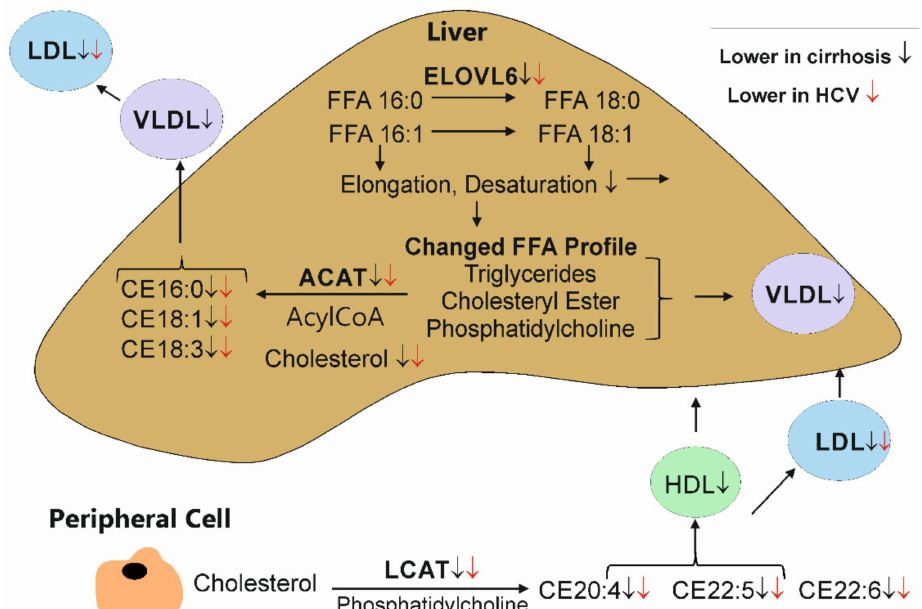
Figure 9. Pathways which may contribute to the altered CE profile in HCV and liver cirrhosis. Free cholesterol in the liver is converted to CEs by ACAT, which produces atherogenic CE species. These are released from the liver by VLDL, which is converted to LDL in the circulation. Elongation of very-long chain fatty acids (ELOVL) 6 was found to belower expressed in the fibrotic liver, and activity of further elongases and desaturases may be impaired. Free fatty acids (FFA) are used for the synthesis of various lipid classes such as triglycerides, diacylglycerols, cholesteryl ester and phosphatidylcholine. LCAT in serum uses phosphatidylcholine to esterify cholesterol derived from peripheral cells and tissues. Here, highly unsaturated CE species are being formed. The CE species (found in the current work to be low when cirrhosis was defined by ultrasound), lipoproteins and enzymes which are reduced in cirrhosis are marked with a black arrow. A red arrow marks CE species and lipoproteins, which are low in HCV infection. Current findings are in agreement with improved ELOVL6, ACAT and LCAT activity at the end of DAA therapy. This is in line with a higher CE/FC ratio at therapy end. Whether the levels of these enzymes are reduced or FFA availability is limited must be experimentally clarified. ↓ Lower in cirrhosis, ↓ Lower in